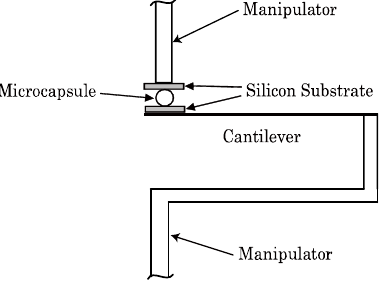
Fig.1 Micromanipulator for microcapsule compression